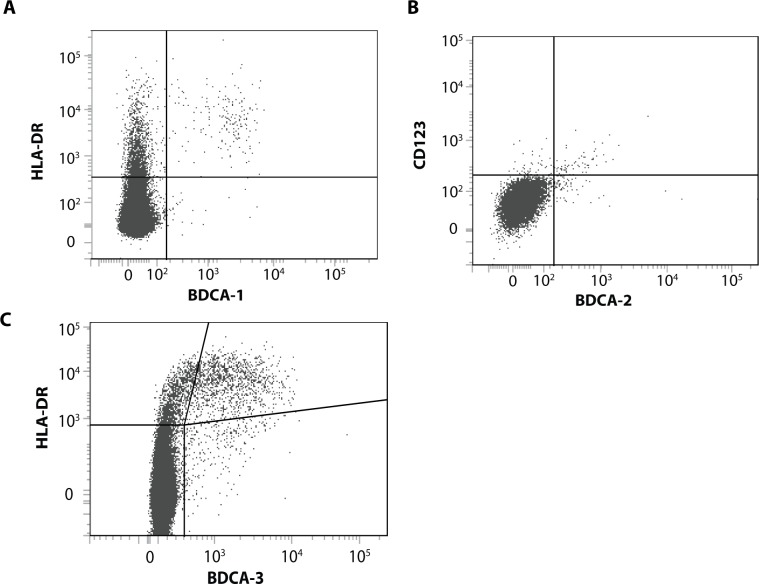
Gating strategy for each subtype of DCs: (A) BDCA1-positive mDCs; (B) BDCA3-positive mDCs; (C) pDCs.